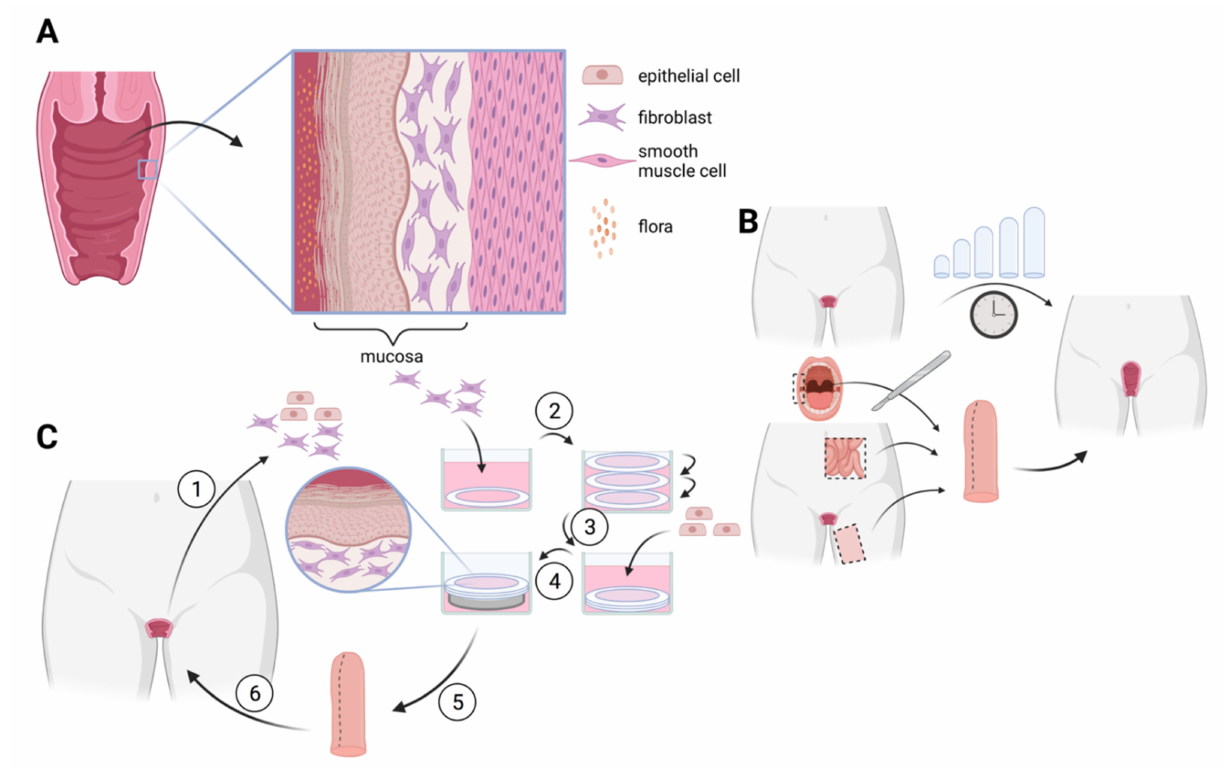
Figure 4. Techniques for neovagina formation: ( A ) Histoanatomy of the vagina. A glycogenated stratified squamous epithelium lies atop a stroma forming the vaginal mucosa which is above the muscularis of uterine origin. ( B ) Vaginal dilation is the first line of treatment for MRKH patients ( top ). Surgical options are available, relying of heterotopic tissue substitutes. ( C ) Tissue engineering could allow for autologous vaginal mucosa grafting in MRKH patients. The “self-assembly” method is scaffold-free as fibroblasts secrete ECM components in the presence of ascorbic acid. Fibroblast-ECM sheets are fused and seeded with epithelial cells for histologically similar autologous tissue in vitro that has shown promising results in murine models. Numbers indicate procedure order. Figure created with